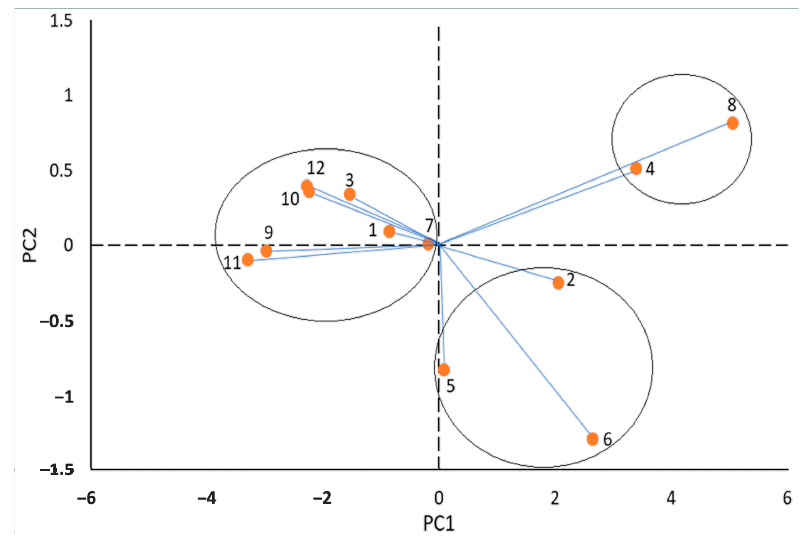
Figure 4. PCA biplot graphics of measured variables in saffron flowers grown under different conditions: 1 = GA 3 +white light, 2 = GA 3 +blue light, 3 = GA 3 +red light, 4 = GA 3 +combined B&R light, 5 = GABA+white light, 6 = GABA+blue light, 7 = GABA+red light, 8 = GABA+combined B&R light, 9 = control+white light, 10 = control+blue light, 11 = control+red light, and 12 = control+combined B&R light.